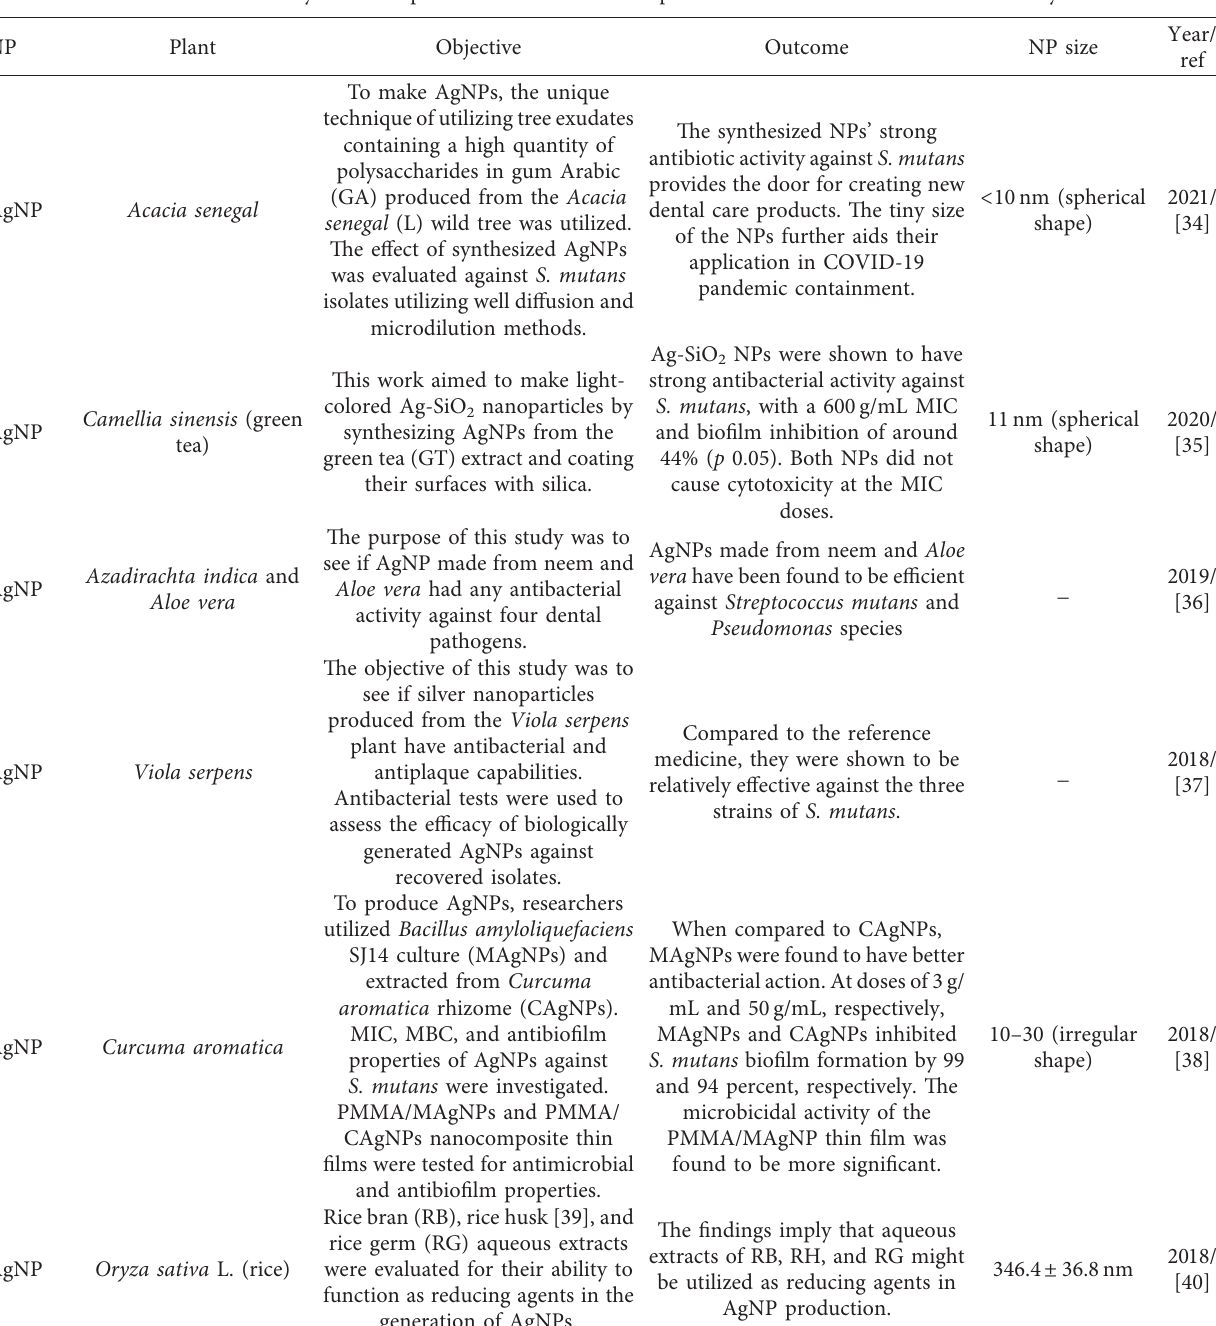
Table 1: Green synthesis of plant-mediated metal nanoparticles which have been used in dentistry. NP